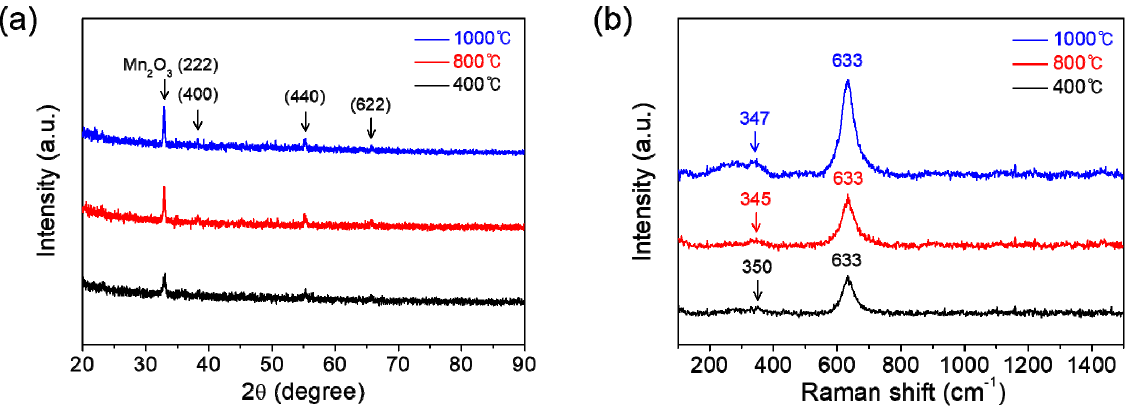
Figure 2. TGA and the derivative TGA curves of manganese 2-ethylhexanoate solution, acquired in ( a ) air and ( b ) Ar.